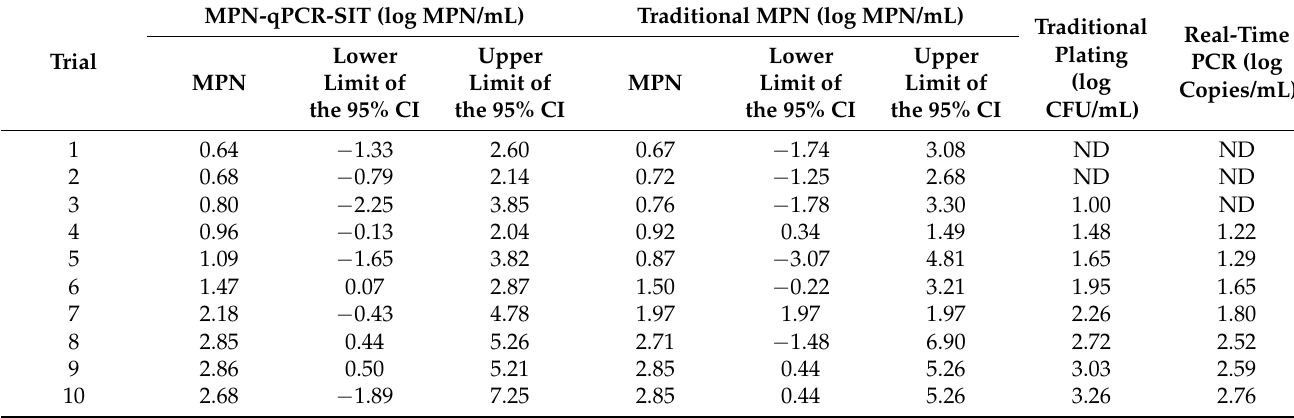
Table 5. Population determination of S. enteritidis (log MPN/mL or log CFU/mL) by different methods including the traditional plating, traditional MPN, TaqMan real-time PCR, and the